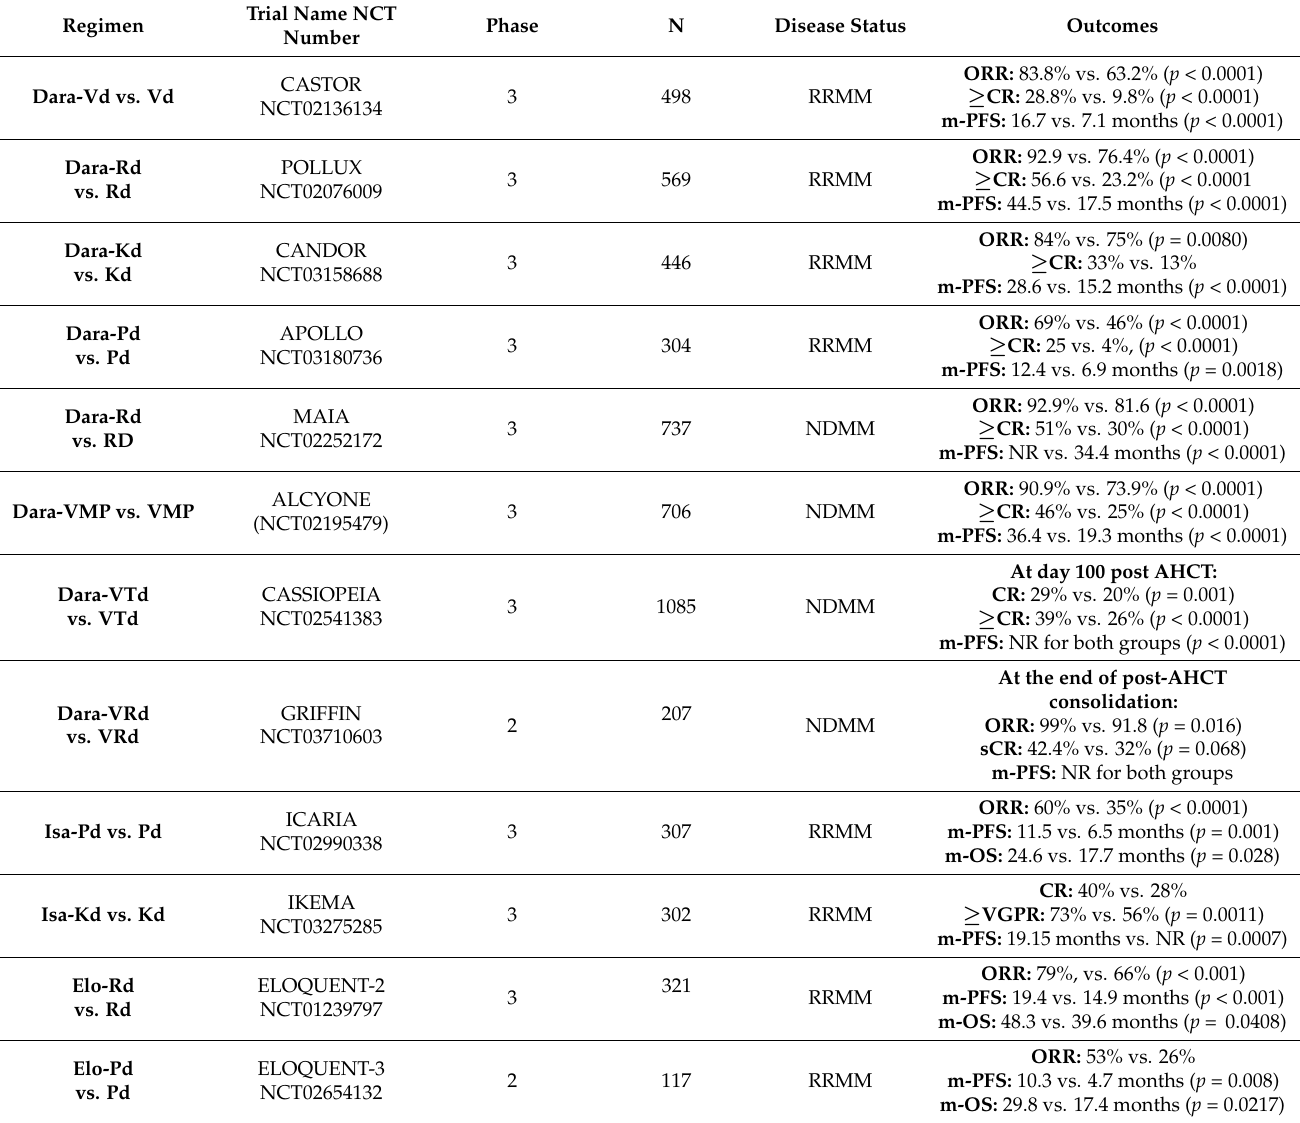
Table 1. Major clinical trials of the standard-of-care regimens for MM currently used in routine clinical